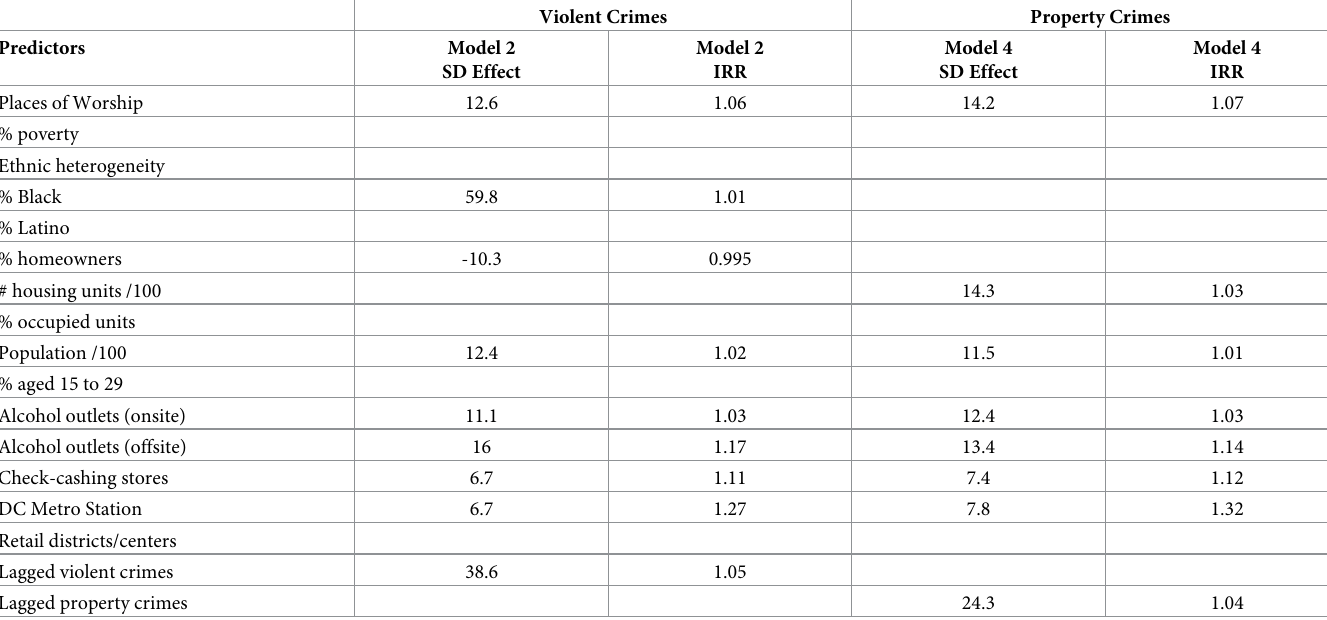
Table 3. The substantive effects of predictors from full